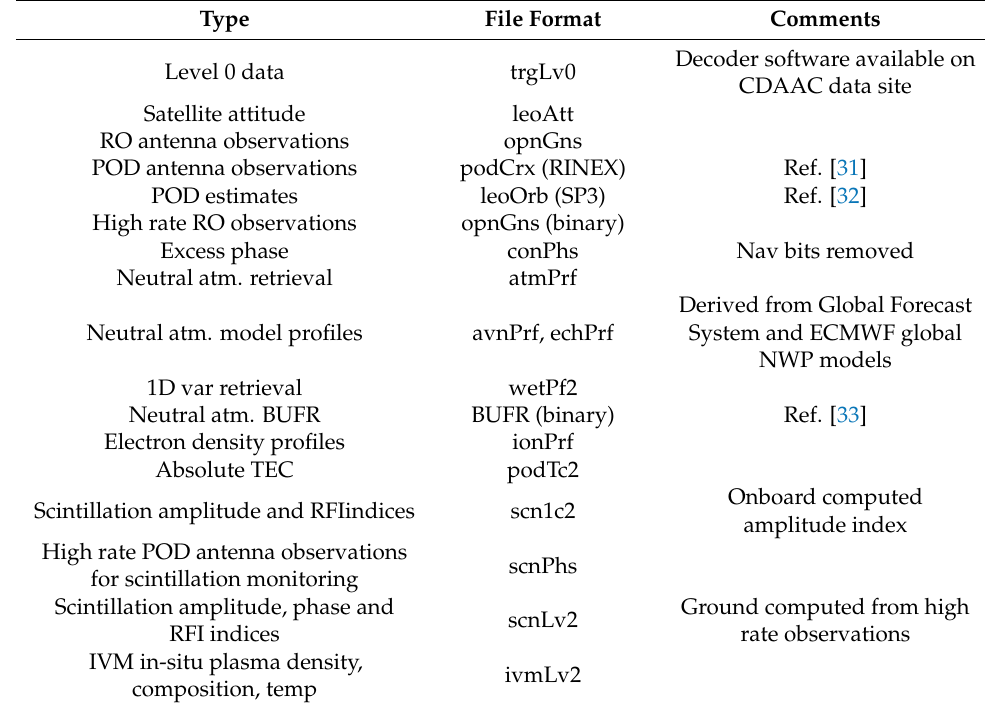
Table 5. Available data products. Unless otherwise noted, file formats are NetCDF and documented at CDAAC and CWB [29,30].